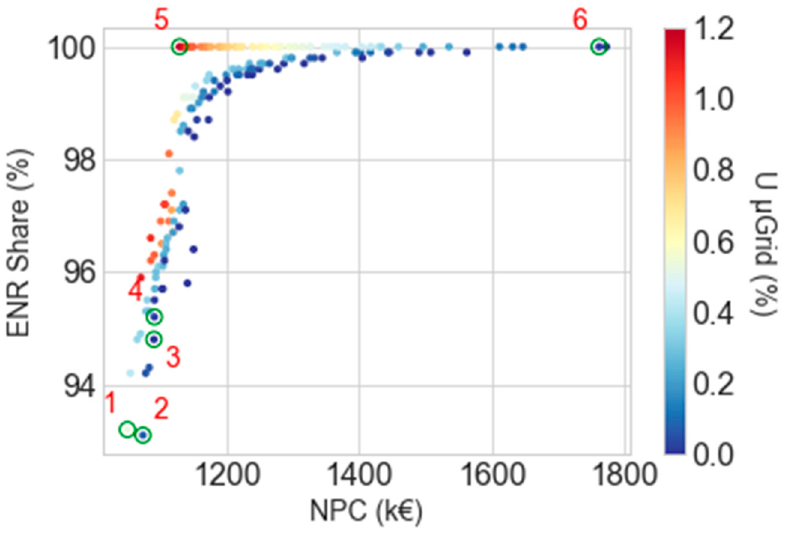
Figure 8. 2D Pareto front with the third objective of reliability shown in color and six selected configurations of interest.